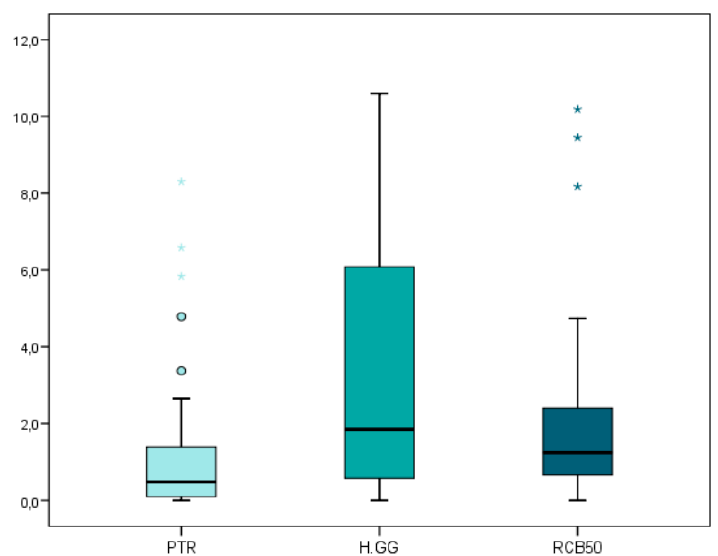
Figure 5. Box plot of the proportion of remaining carrier-based root canal filling material (%) regarding the non-surgical endodontic retreatment techniques. PTR: ProTaper Retreatment endodontic rotary instruments; RCB50: Reciproc Blue endodontic reciprocating instrument; H-GG: combined root canal retreatment technique between Gates-Glidden drills and Hedstrom files.